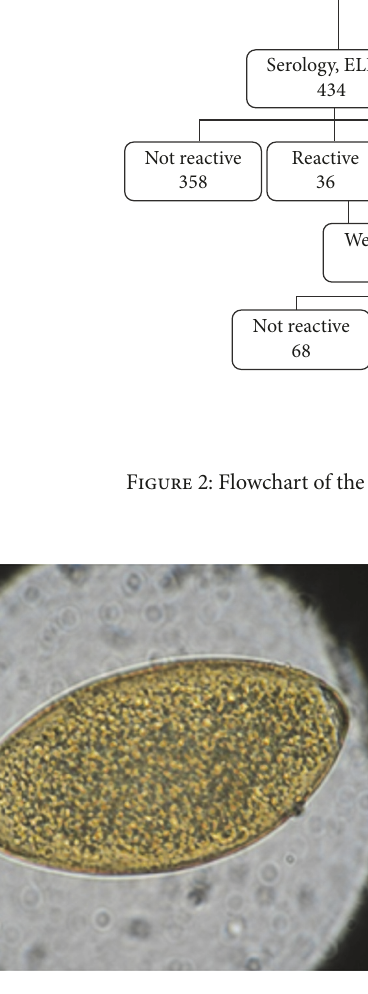
Figure 3: The image of an egg from Fasciola hepatica found in fecal material of one participant is shown as seen under the microscope at 400x magnification; its size was 143 𝜇 m by 75 𝜇 m.